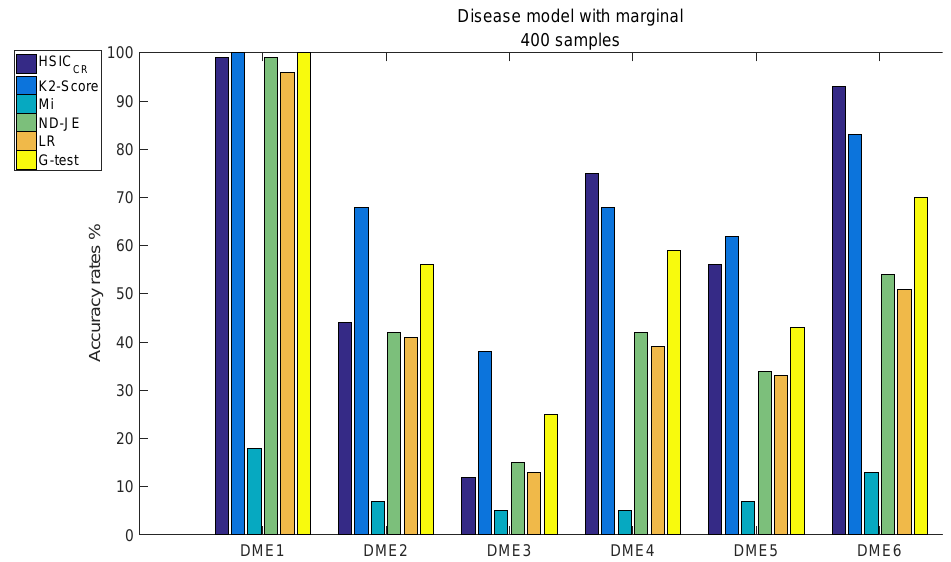
Figure 5. Disease model with marginal effects, with 400 samples and k =